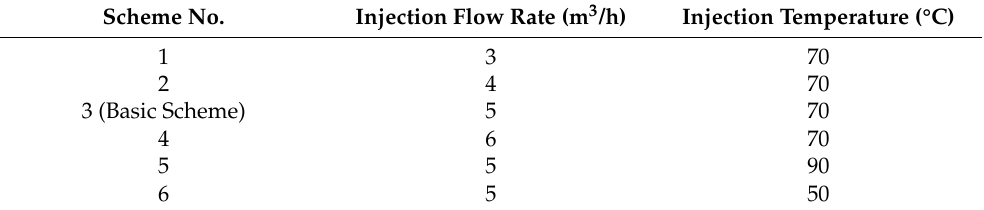
Table 4. Simulation schemes of different injection flow rates and temperatures. Scheme No.